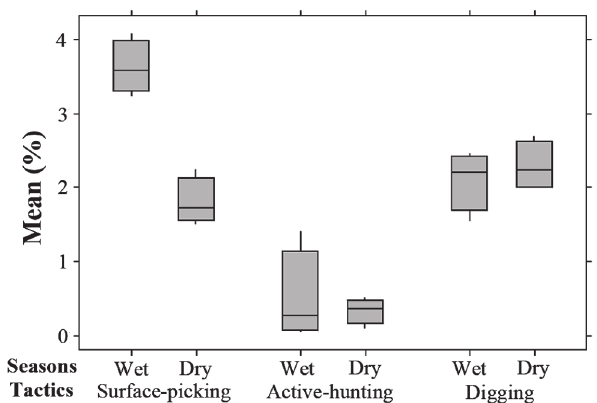
Fig. 2. Mean values of proportion of time expressing different foraging tactics by Brycon devillei for each season in the RPSP, between July 2006 and April